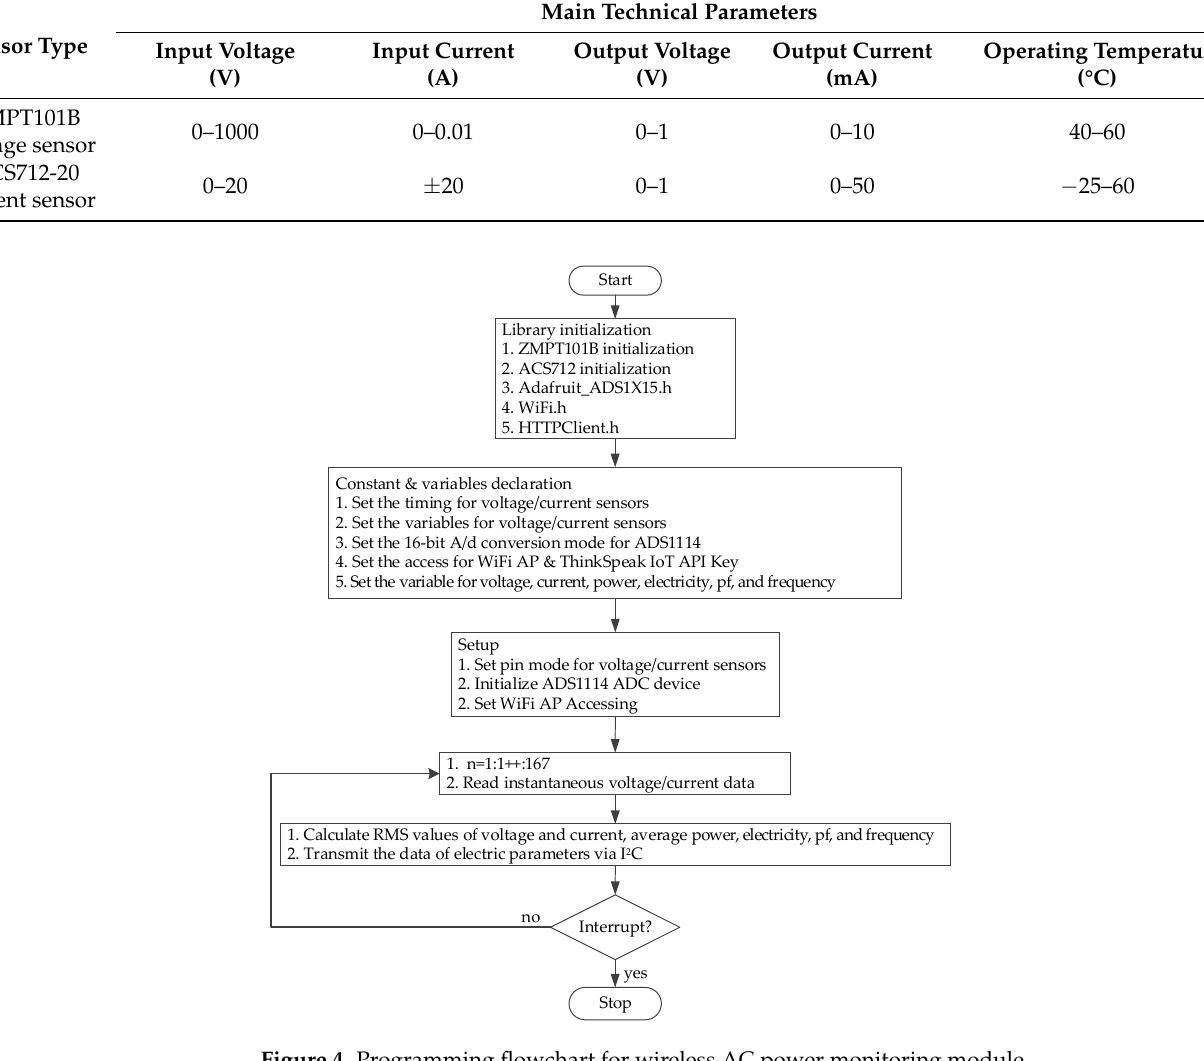
Figure 4. Programming flowchart for wireless AC power monitoring